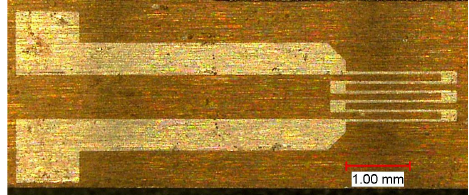
Figure 5. Overview of the structured thin film